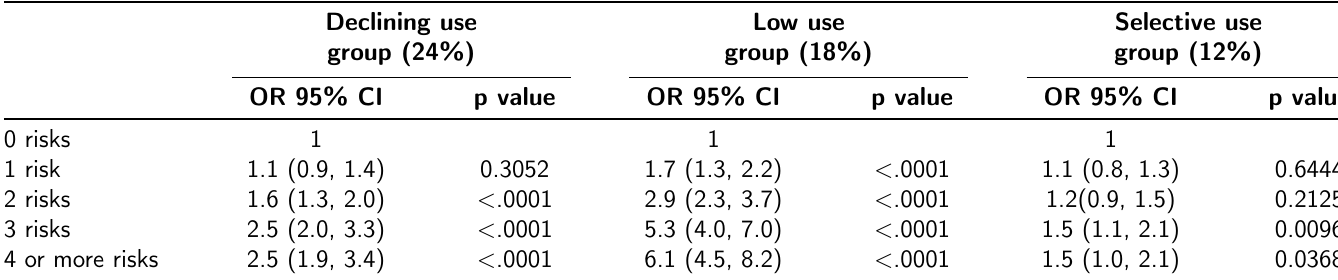
Table 2: Associations between cumulative risks and declining, low and selective service use group membership, relative to the regular service use group